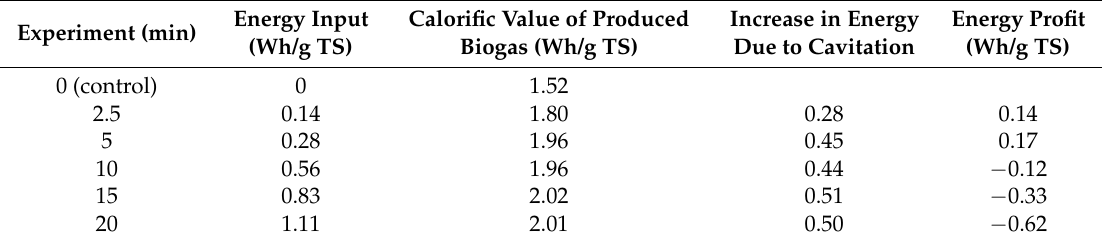
Table 3. Calculation of the economic efficiency of the hydrodynamic cavitation of